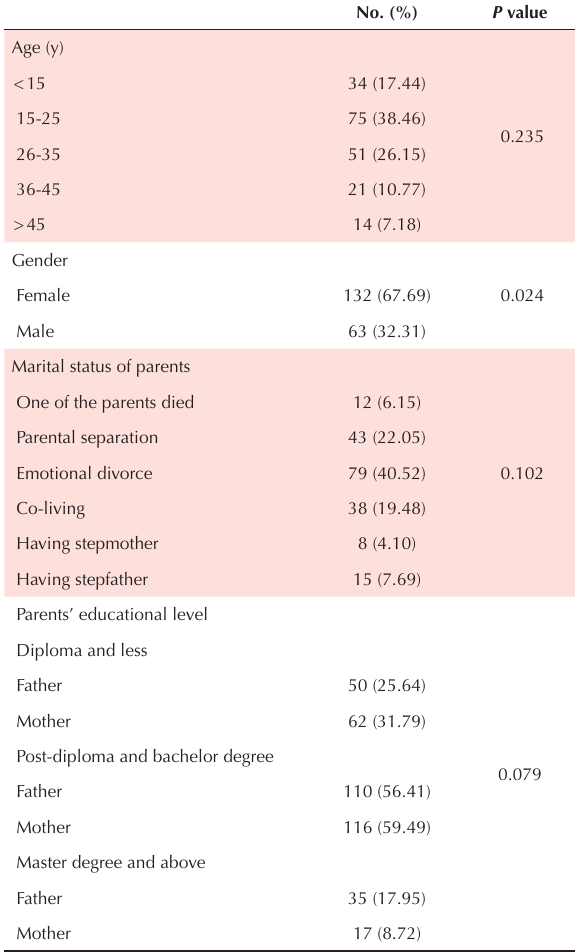
Table 1. Demographic information of